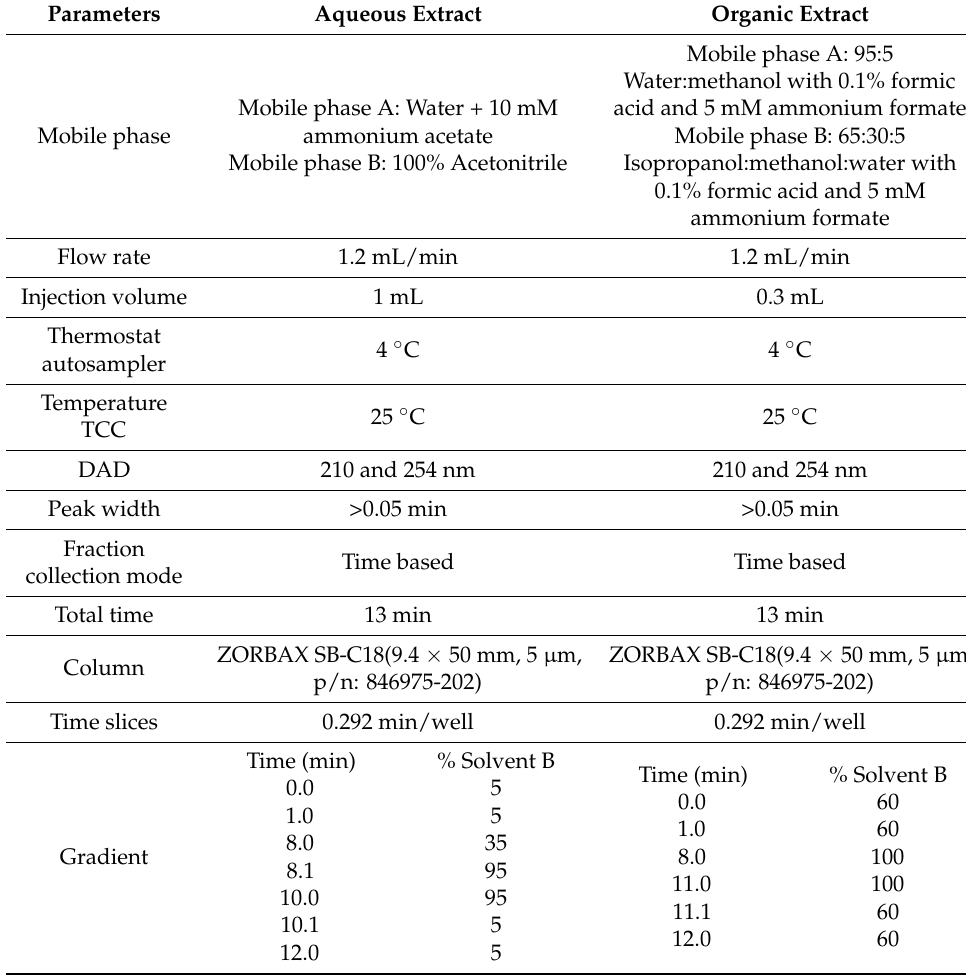
Table 1. Chromatographic parameters for